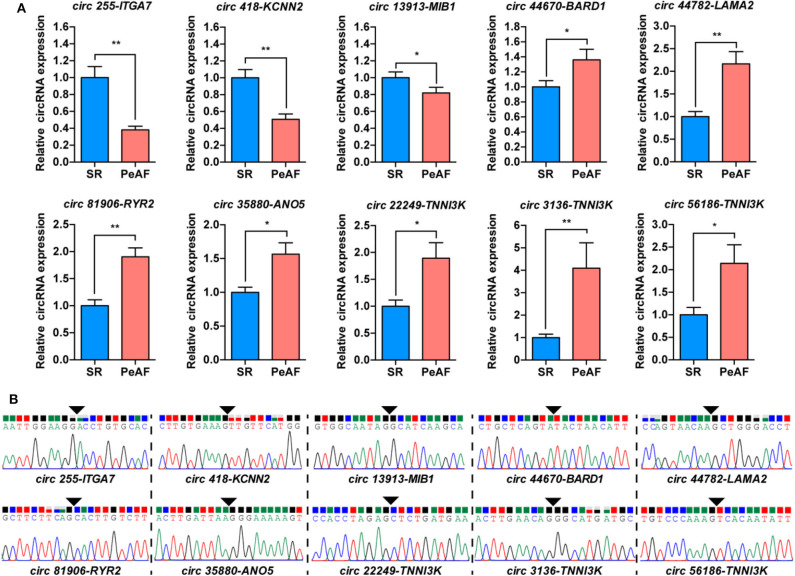
Validation of circRNAs between SR and PeAF group. (A) qRT-PCR results of selected circRNAs. circ 255-ITGA7, circ 418-KCNN2, and circ 13913-MIB1 were downregulated in PeAF group; circ 44670-BARD1, circ 44782-LAMA2, circ 81906-RYR2, circ 35880-ANO5, circ 22249-TNNI3K, circ 3136-TNNI3K, and circ 56186-TNNI3K were upregulated in PeAF group. (B) Sanger sequencing of backsplicing site of circRNAs selected for validation. Black triangle means backsplicing junction site. *p < 0.05; **p < 0.01.